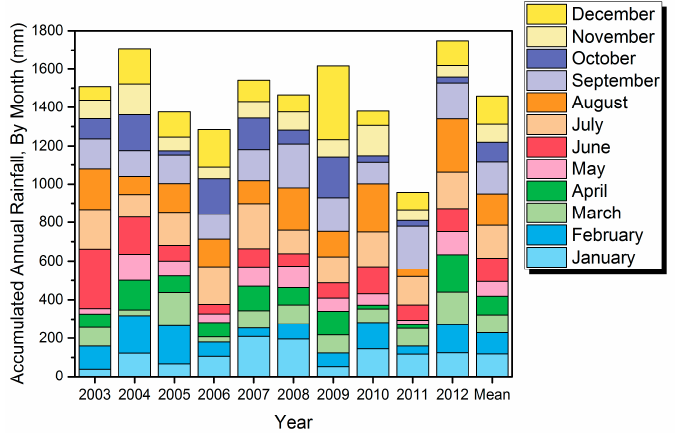
Figure 4. Tropical Rainfall Measurement Mission (TRMM) accumulated monthly rainfall, 2006. ( A ) January; ( B ) April; ( C ) July; ( D ) October. Note color scale changes for each panel, units are mm.